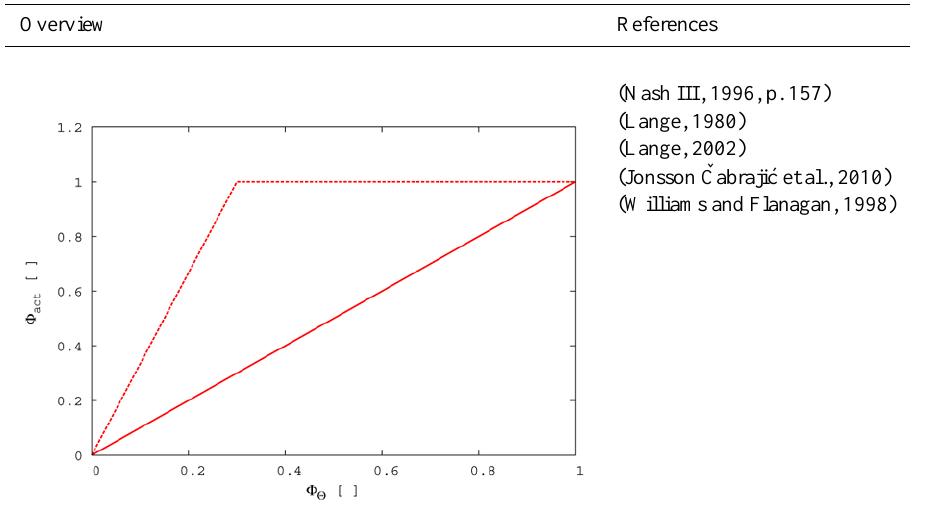
= 0 . 3 and the solid line 2, sat